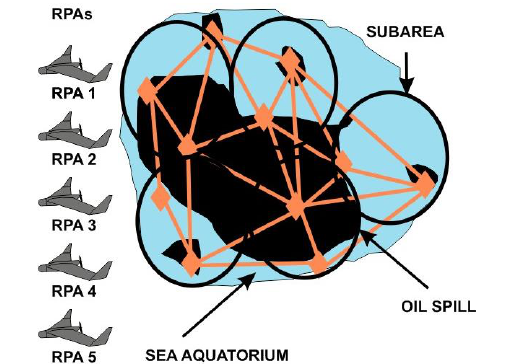
Fig. 2. A complex approach for oil